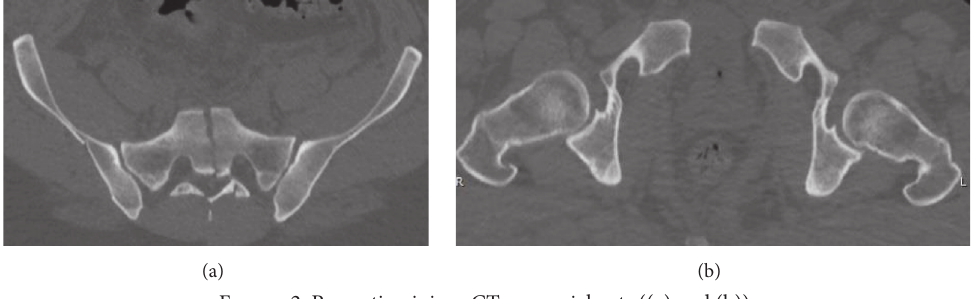
Figure 2: Presenting injury CT scan axial cuts ((a) and (b)).